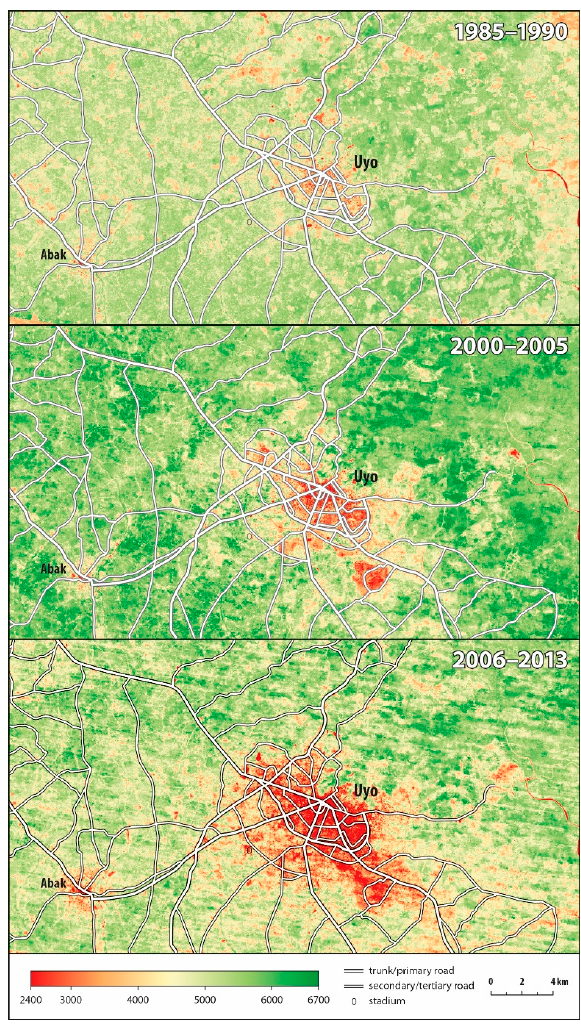
Figure 3. Median normalized difference vegetation index (NDVI) for the study area.